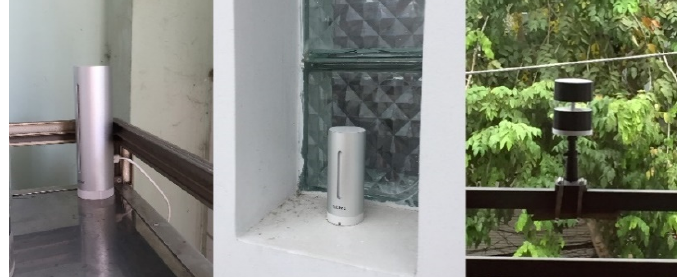
Figure 5. Netatmo weather station (outdoor and indoor units, wind gauge).